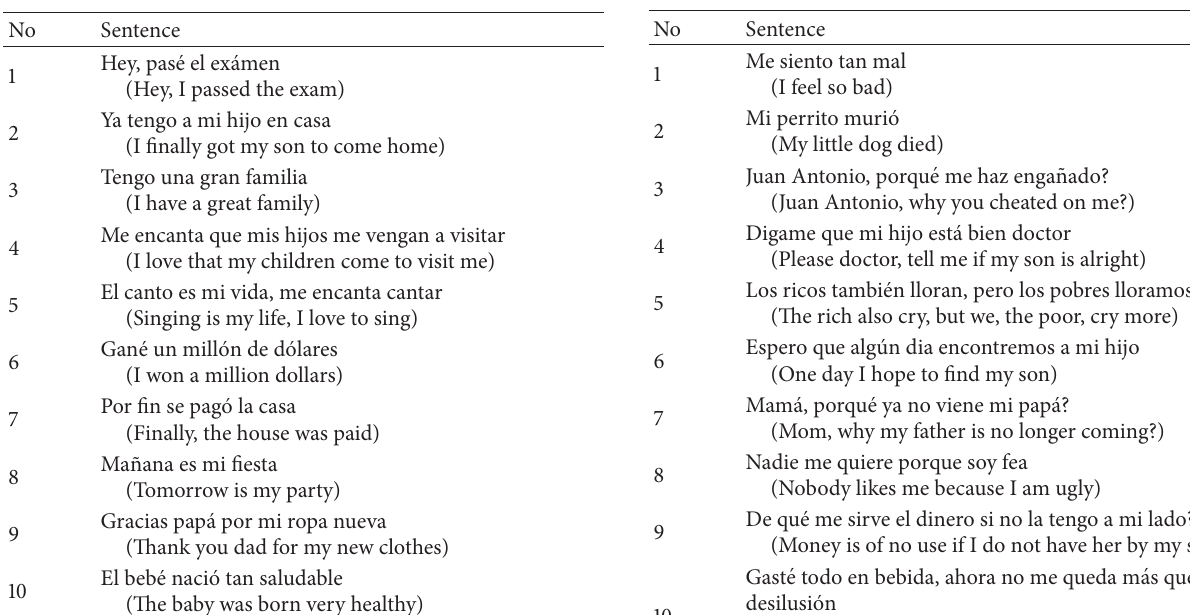
Table 2: Emotional stimuli: “felicidad” (happiness).